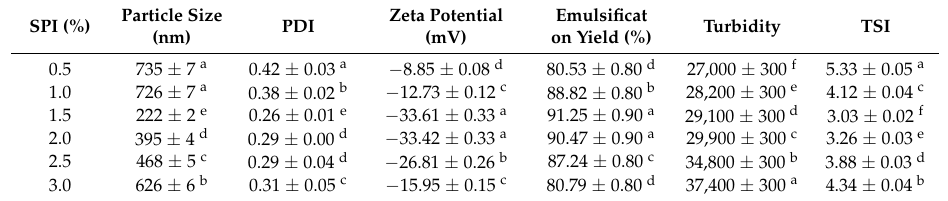
Table 1. Effect of soybean protein isolates (SPI) addition on emulsion stability of nanoemulsions.